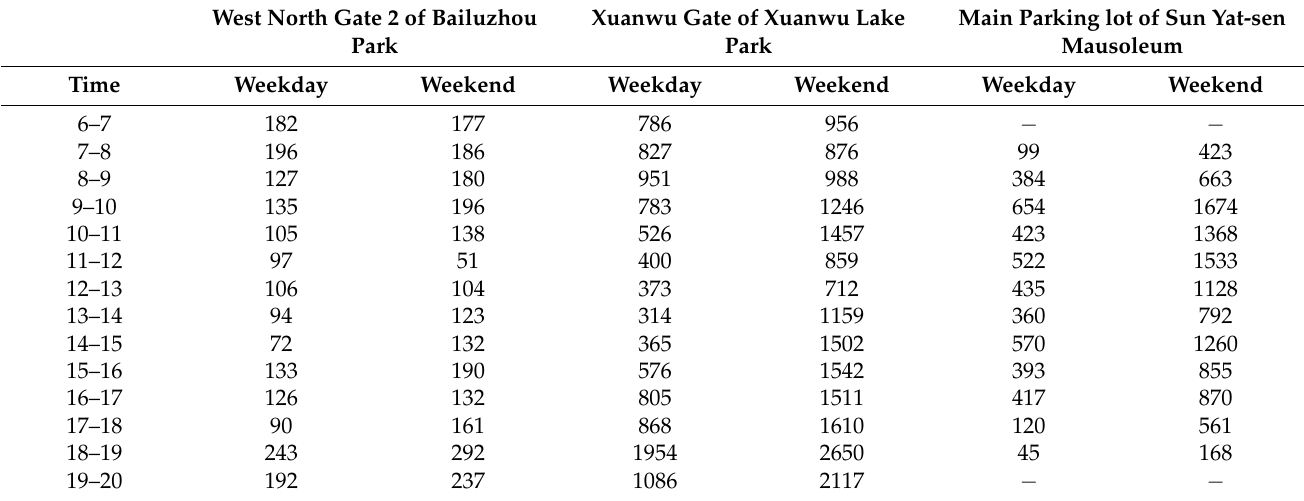
Table 1. Typical number of hourly park entrance visitors, employed in ABM for determining the number of visitors entering the park.